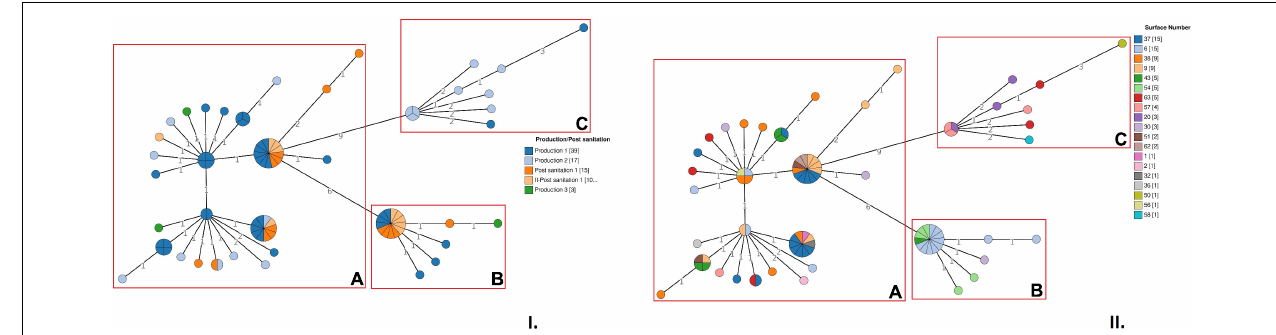
FIGURE 1 | Cluster analysis of Lm strains belonging to ST2801 based on cgMLST profiles. (I) In the minimum spanning tree (MSTv2), strains are colored according to the sampling session. (II) In the MSTv2, strains are colored according to the environmental surface from which they were isolated. The number values between adjacent nodes indicate the number of allelic differences between nodes. Clusters are highlighted with red